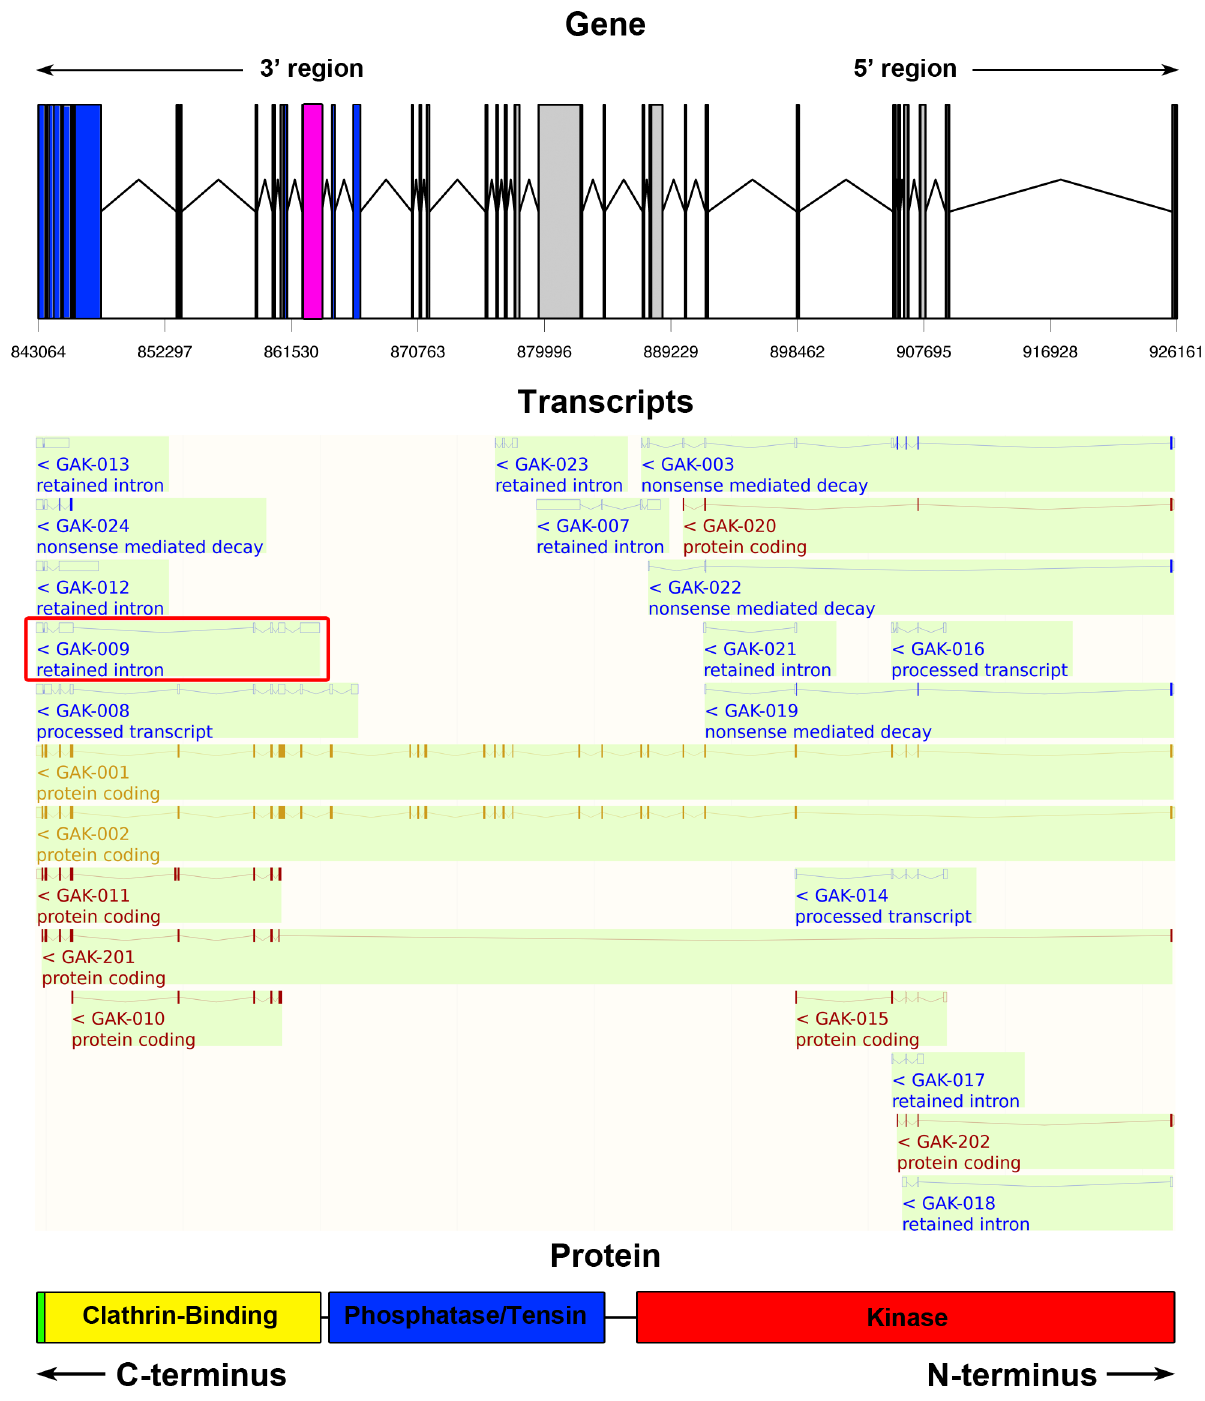
Fig 3. GAK exons significantly associated to case status primarily encode for the clathrin-binding and J domains of GAK protein. GAK exon 25 ( GAK25) , which was found to be associated to both case status and the risk SNP, is highlighted in magenta (under Gene), while GAK exons associated with case status only are highlighted in blue. All Gencode transcripts are shown below the gene structure, with transcript functionality listed below each contig. GAK25 represents the 5 ’ UTR of Gencode transcript 009 (Boxed in red). The GAK protein domains (under Protein) are denoted by color: J domain (green), clathrin-binding domain (yellow), phosphatase/tensin domain (blue), and kinase domain (red). Transcript data from